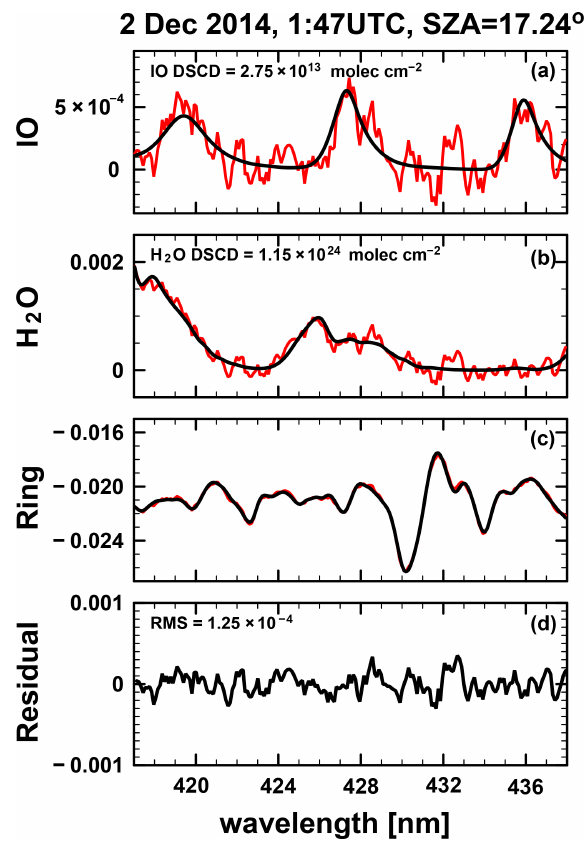
Figure 1. Nonlinear least squares spectral fitting results for IO con- centrations observed on 2 December 2014. Panels (a) and (b) show the fitting for IO and H 2 O. Black lines represent the cross section scaled to the spectrum (red) determined by differential optical ab- sorption spectroscopy. Panels (c) and (d) show the Ring effect con- tribution and the residual spectrum.